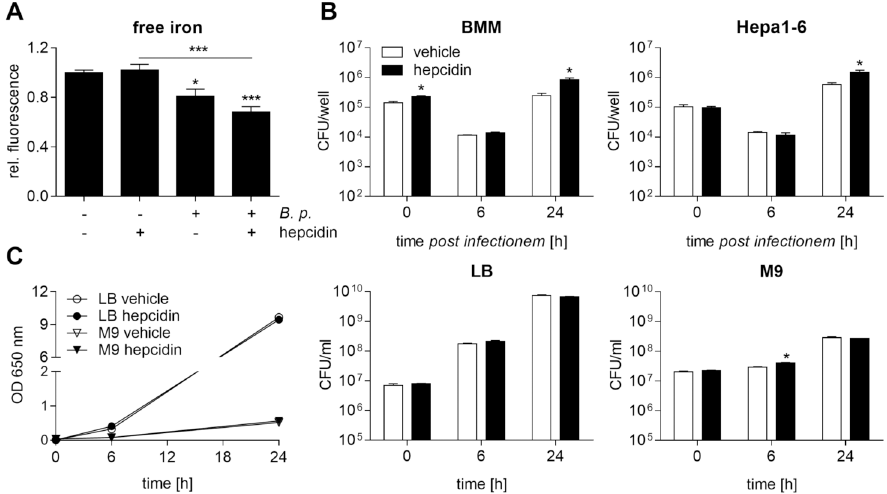
Fig 2. Exogenously added hepcidin leads to increased iron levels stimulating intramacrophage replication of B . pseudomallei . BMM or murine hepatoma Hepa1-6 cells were treated with hepcidin (1 μ g/ml) or corresponding vehicle (A. bidest) for 20 hours followed by infection with B . pseudomallei at MOI 50 (BMM) or MOI 200 (Hepa1-6). (A) Intracellular free iron levels were determined after 24 hours in BMM using the iron-sensitive fluorescent probe Phen Green SK. Data are presented as mean with SEM of triplicate determinations (n = 3). Statistical analyses were performed using one-way ANOVA and the Bonferroni post-hoc test ( (cid:3) p < 0.05, (cid:3)(cid:3)(cid:3) < 0.001). (B) Invasion (0 h) and intracellular growth (6 h, 24 h) of B . pseudomallei were examined by kanamycin protection assay. Data are expressed as mean with SEM of triplicate determinations (BMM, n = 3; Hepa1-6, n = 4). Statistical analyses were done using Student’s t- test ( (cid:3) p < 0.05). (C) LB broth or M9 minimal medium with or without hepcidin (1 μ g/ml) or corresponding vehicle was inoculated with B . pseudomallei . The optical density (OD) at 650 nm and colony forming units (CFU)/ml were determined at indicated time points. Data are presented as mean with SEM of duplicates. Statistical analyses were performed using Student’s t- test ( (cid:3) p <